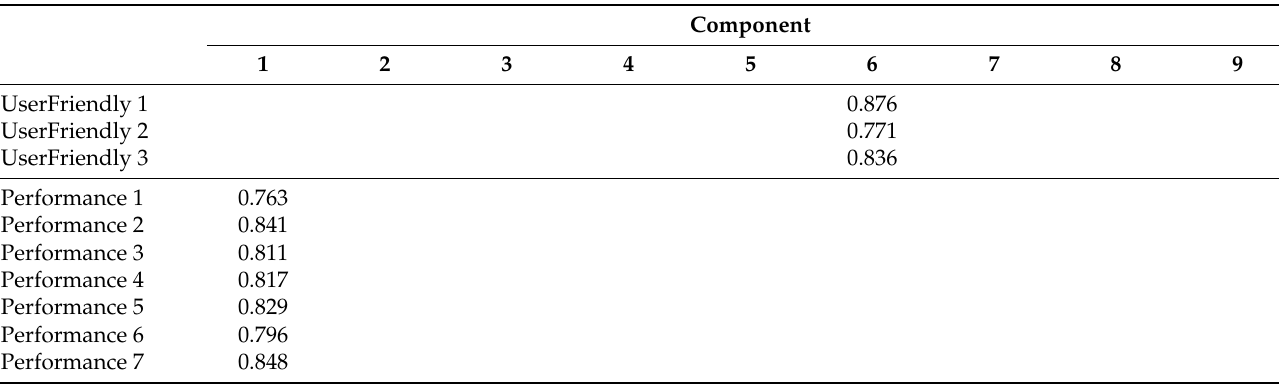
Table 2. Final survey evaluation through rotated component